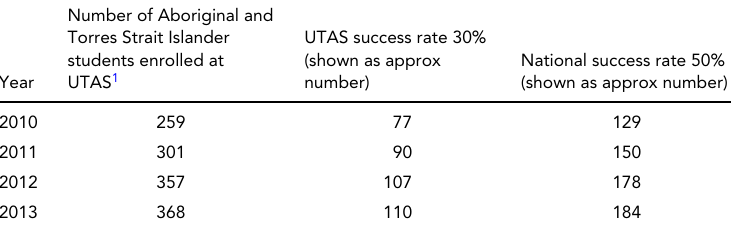
UTAS Aboriginal and Torres Strait Islander Success Rate Compared to the National Success Rate for Students